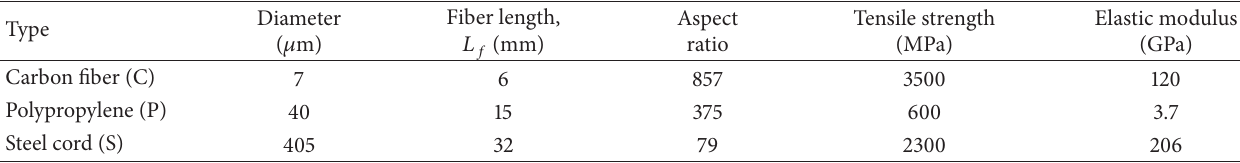
Table 1: Dimensions and mechanical properties of composite fibers.